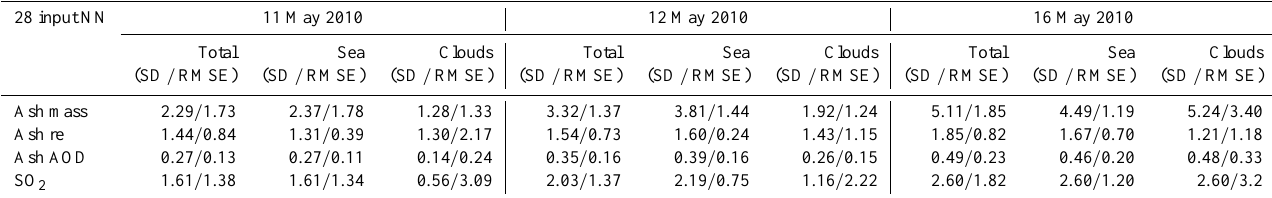
Table 7. RMSE values related to ash parameters and SO 2 for the independent validation sets. 28 input NN